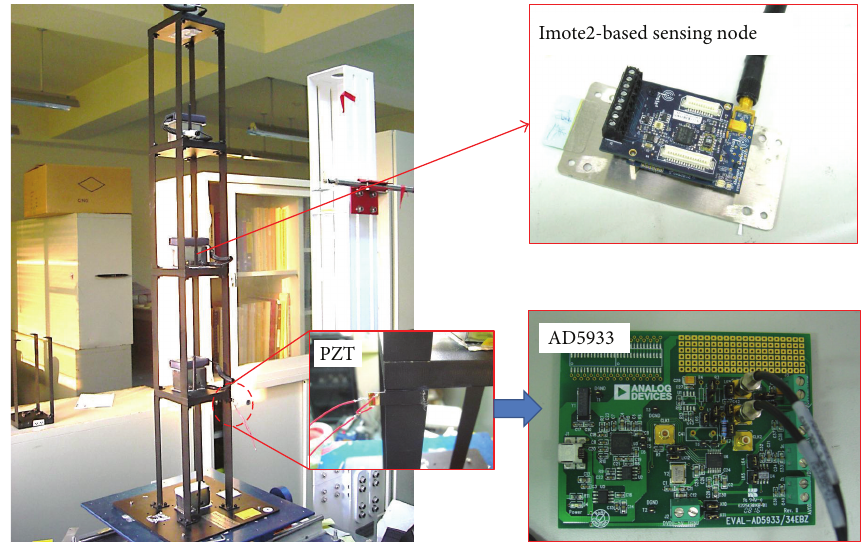
Figure 9: Experimental setup for wireless SHM system and impedance measurement